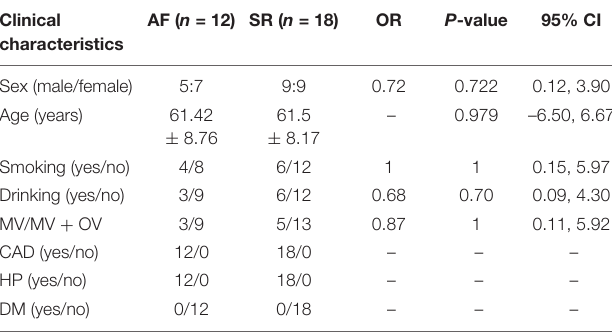
TABLE 1 | Clinical characteristics of AF and SR groups. Clinical AF ( n = 12) SR ( n = characteristics